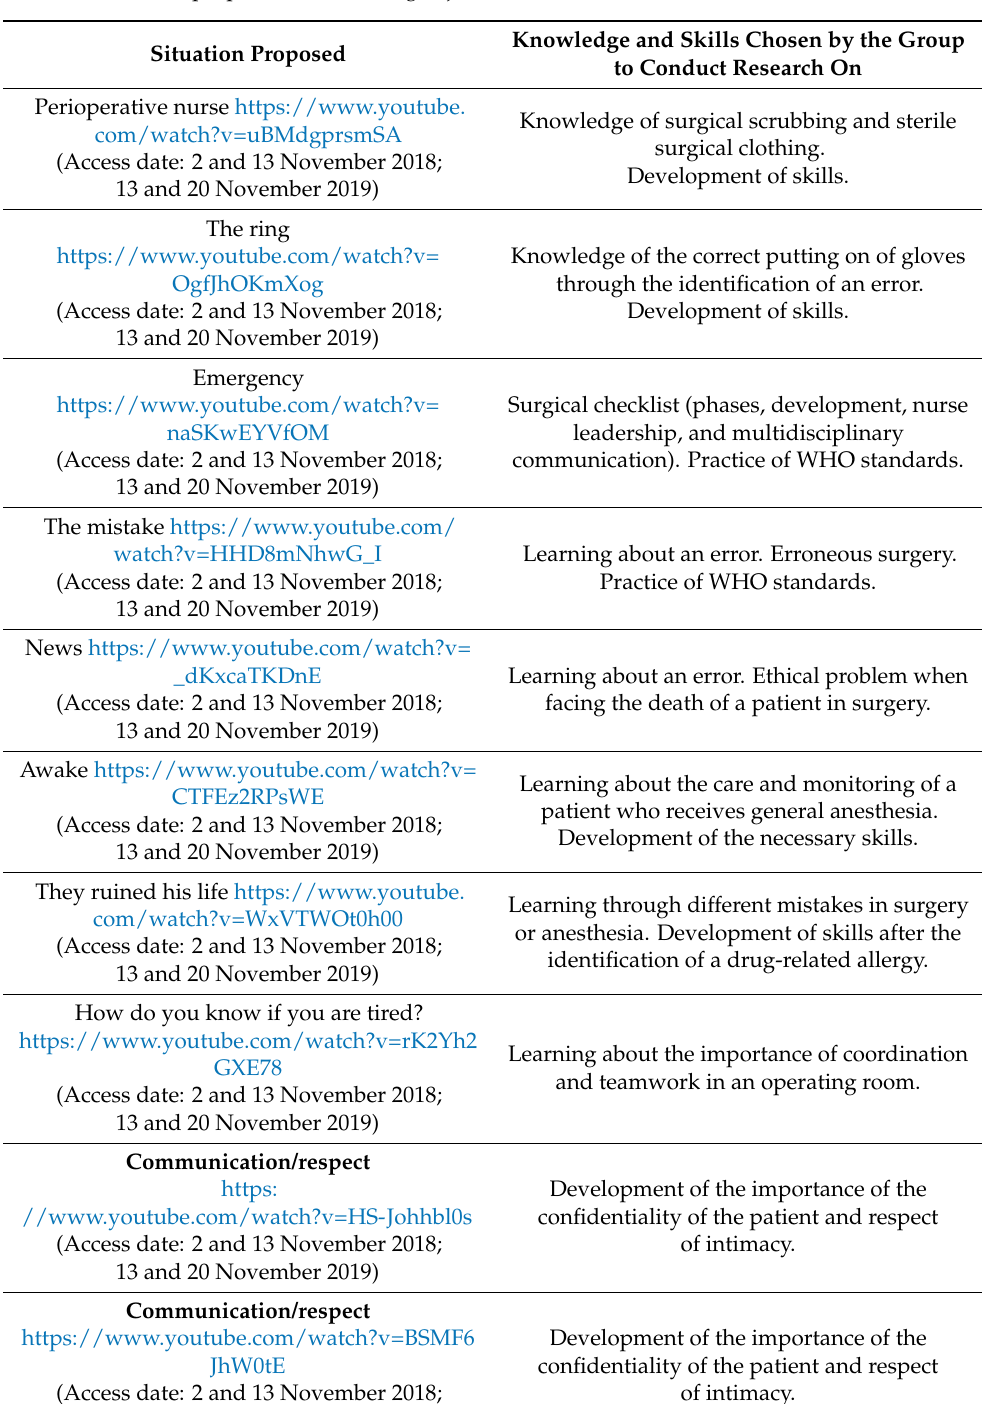
Table 1. Situations proposed and learning